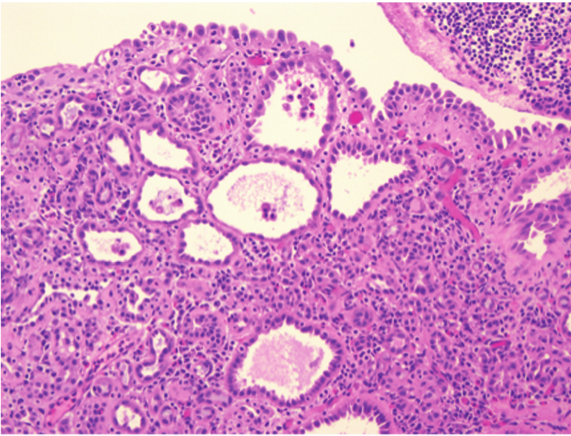
figure 2 - The papillary cores are lined by a single layer of cuboidal epithelium. They contain acing structures and dilated